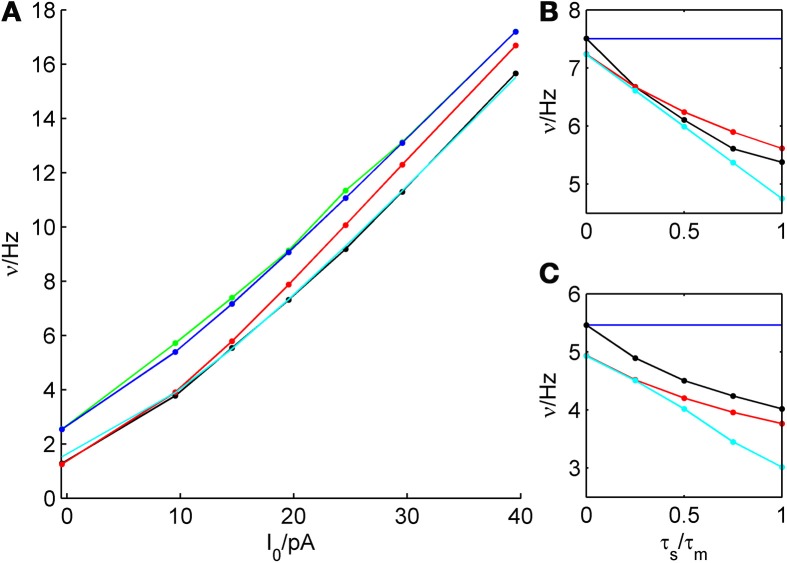
Dependence of firing rate prediction performance on synaptic kinetics. For an average bitufted interneuron, the theoretical predictions in the white noise and colored noise case are shown and compared to simulations. (A): ν-I curve, parameters given in Table 1, σIsyn = 250 pA, τs/τm = 1/2. (B): σIsyn = 200 p, μIsyn = rheobase, b = 5 pA. (C): σIsyn = 200 pA, μIsyn = rheobase, b = 30 pA. Green: simulation, white noise; blue: theoretical prediction, white noise; black: simulation, colored noise; red: theoretical prediction (reduction of variance), colored noise. cyan: theoretical prediction by Equation (34), colored noise.